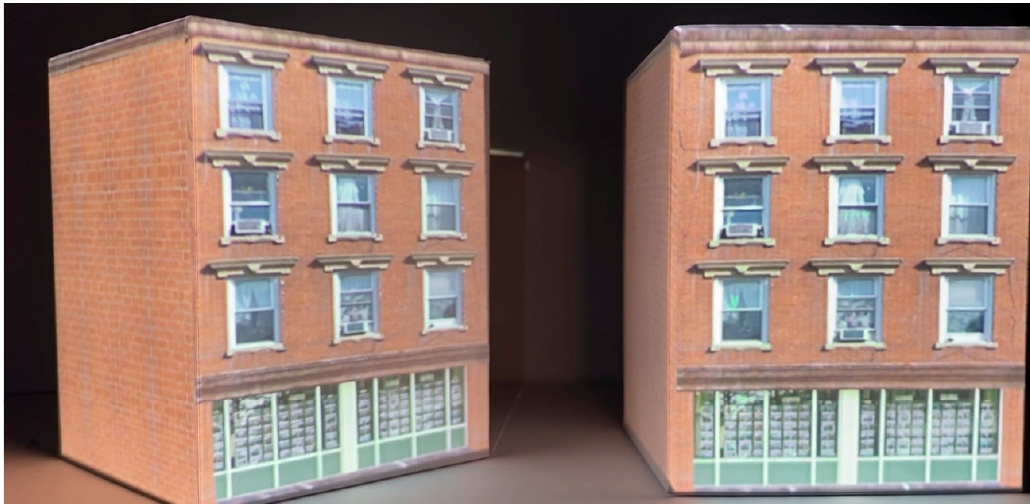
Figure 7. Comparison of projection results on planar/curved surfaces with various building textures. ( a , b , e , and f ) Building textures of stone; ( c ) Building texture of brick; ( d ) Building texture of column pattern. Figure 6. Comparison of projection results in di ff erent projection